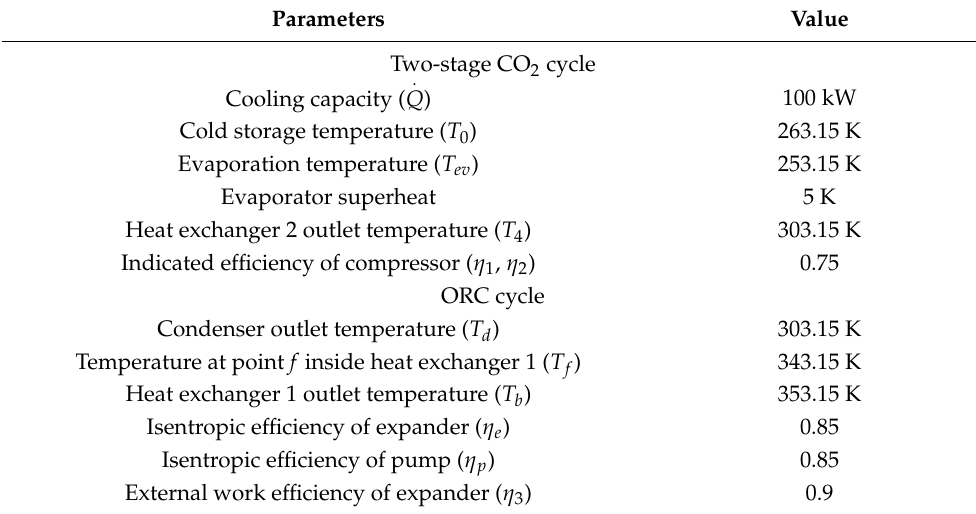
Table 2. Input parameters and values adopted in the thermodynamic